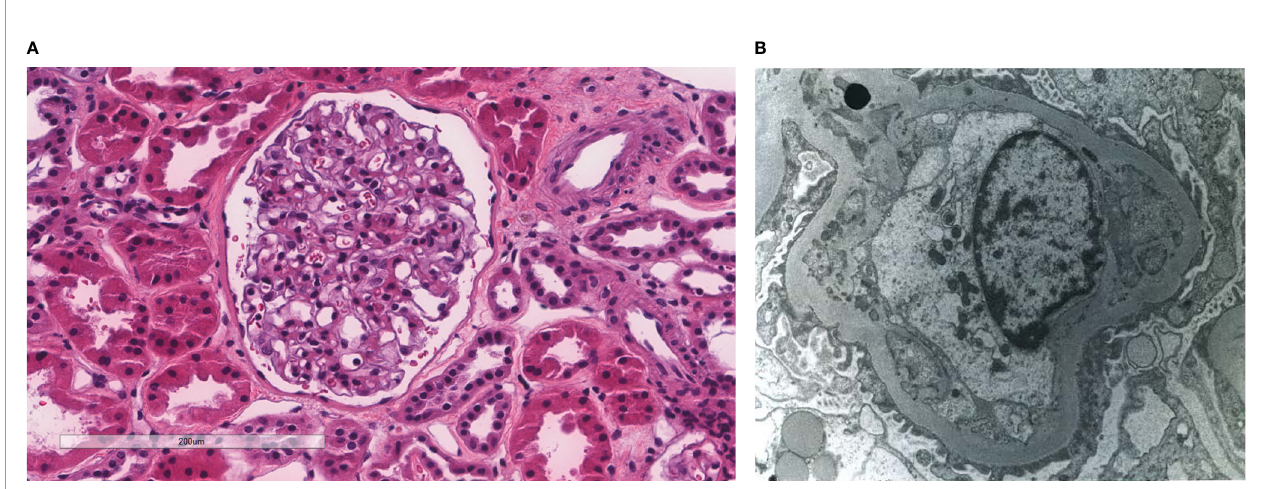
FIGURE 2 | Patient 2. Light microscopy shows an intact glomerulus without hypercellularity or thickened glomerular capillary walls (A) . By electron microscopy, there is prominent widening of the subendothelial space by edema, cell debris, and amorphous proteinaceous deposits. Partial basement membrane reduplication is present (B) .